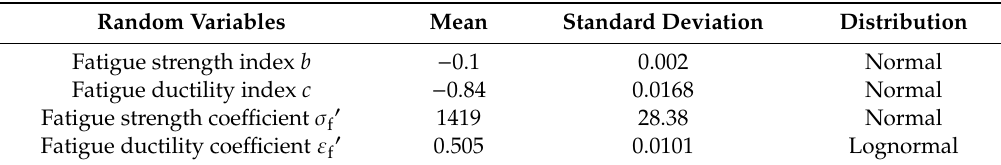
Table 2. Distribution characteristics of model variables.